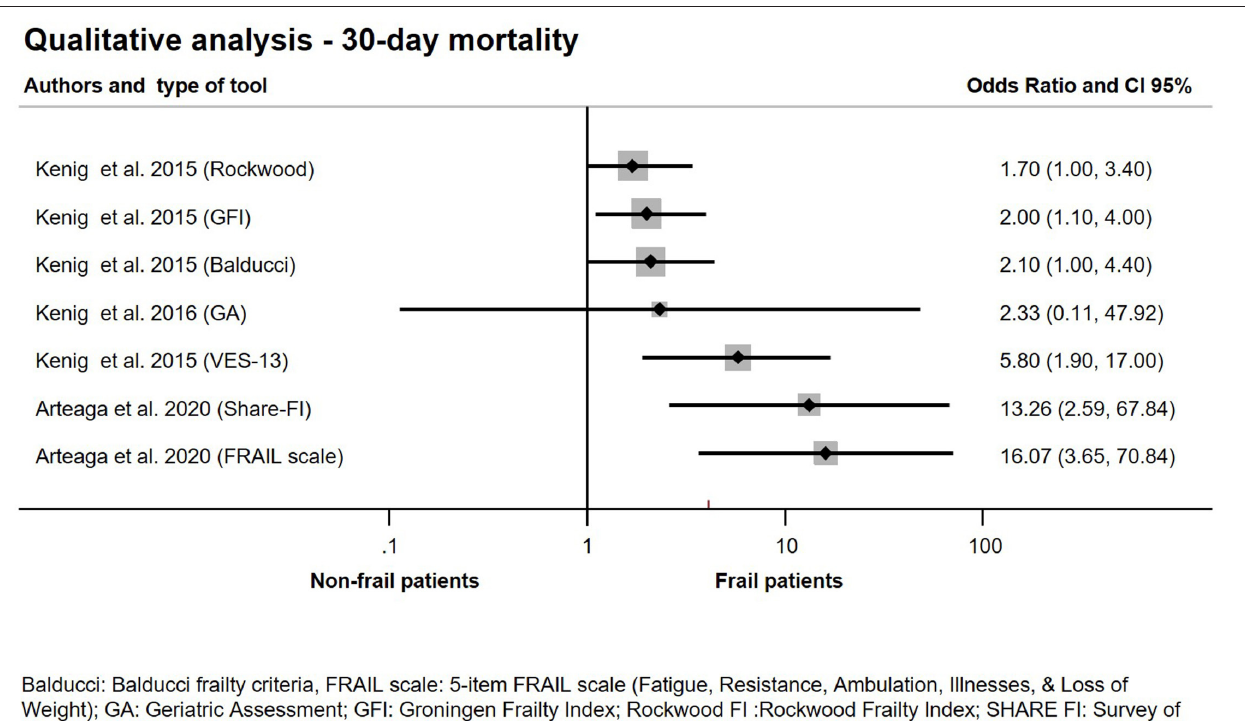
selection are detailed in the PRISMA Flow Diagram shown in Figure 1 . Characteristics of the included studies are summarized in Table 1